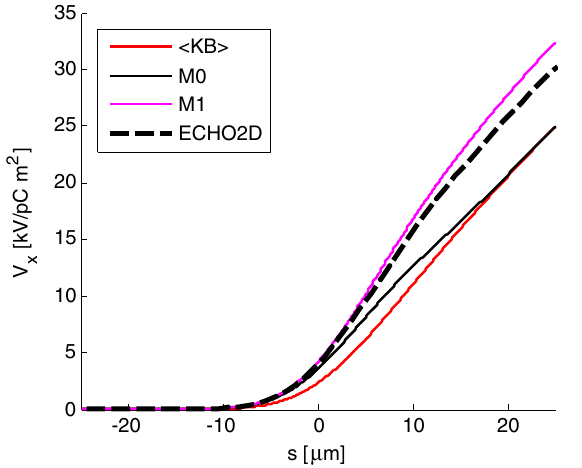
FIG. 9. Short-range longitudinal wake potentials were calcu- ¼ 5 (cid:2) m using different models (solid lated for a bunch of (cid:1) z lines): h KB i (red), M0 (black), M1 (magenta), and ECHO2D code (dashed line).